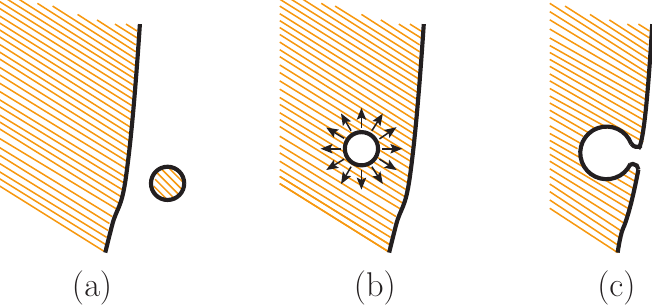
Figure 6. A horizon scale string-wall for N DW = 1 with a small membrane bounded by string. ( a ) A (or a few) horizon scale string(s) and a giant wall attached to it [98]; ( b ) A huge number of small walls bounded by an axionic string which punch holes in the giant walls; ( c ) The punched holes expand with the light velocity and eat up the giant string-walls.